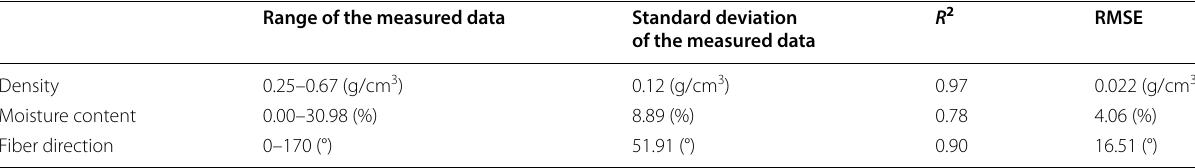
Table 2 Result of the prediction of the density, moisture content, and fiber angle when the interval angle is